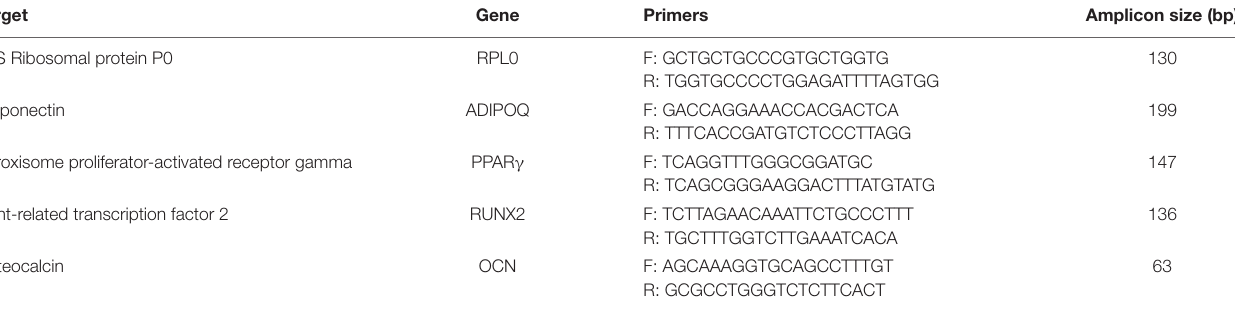
TABLE 1 | List of primers used in the present